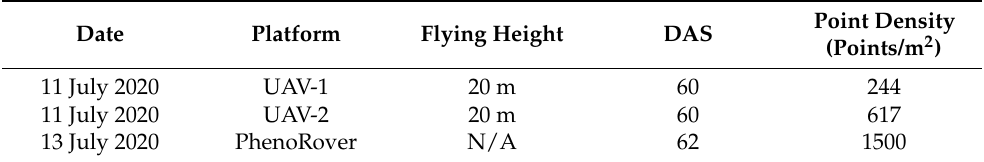
Table 4. Ground point density for the HIPS maize experiment.